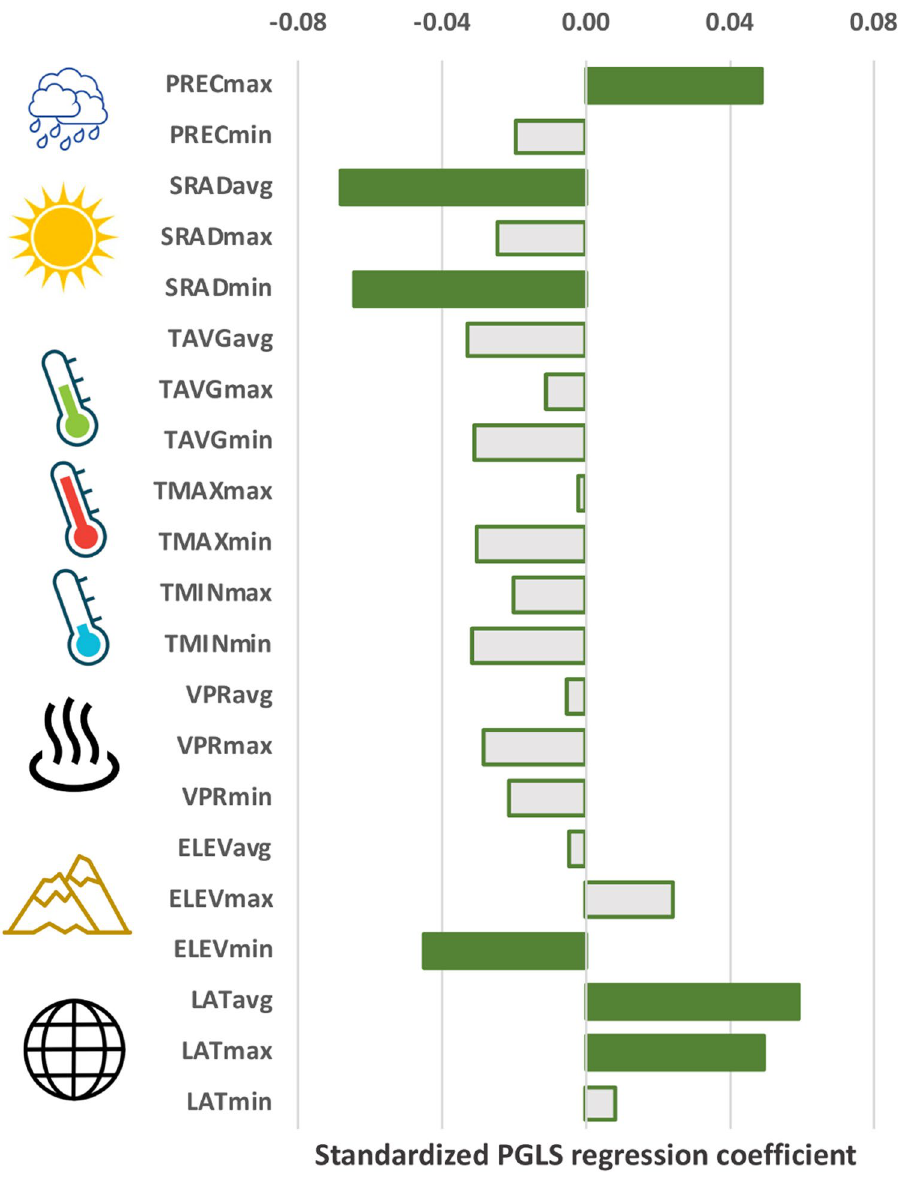
range descriptor